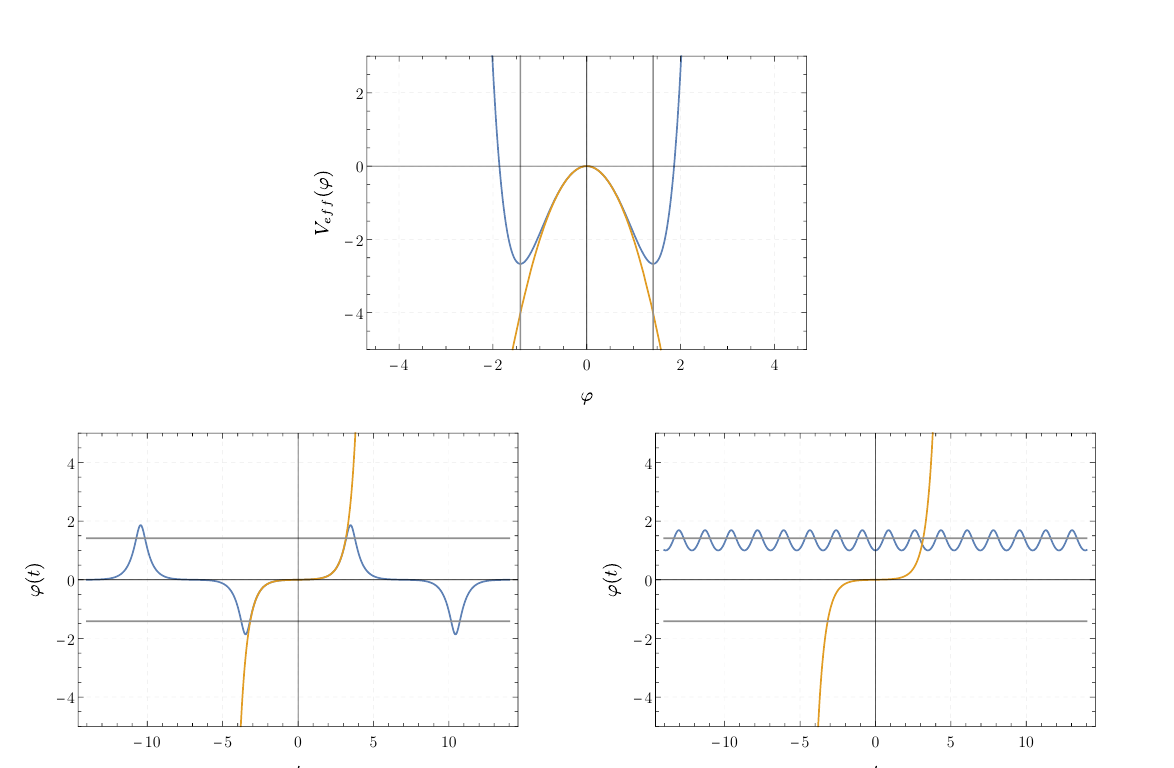
Figure 9 . Effective potential (top panel) and solutions to the field equations (bottom panel) in the case of a free tachyon (orange lines) and a tachyonic field interacting via a toy model for the effective potential, V ( φ ) = c = 1 are used 2 ϕ 2 + ϕ 6 / 6 (blue lines). The parameters m 2 = 2 GeV 2 and c eff th m th ±√ to generate the plots. Two straight gray lines at ϕ = 2 are drawn to facilitate identifying the position of the two minima in all plots. The solution ϕ ( t ) in the bottom-left panel is obtained by using the initial conditions ϕ (0) = 0 and ϕ 0 (0) = 0 . 1 , while the one on the right panel is generated for ϕ (0) = 1 and ϕ 0 (0) = 0 . The motion starts close to the unstable configuration associated with the tachyonic modes, and moves away from it. In the case of a free tachyonic field the potential is unbounded from below, since c 2 < 0 , and this generates the non-oscillating exponentially th m growing modes discussed in the previous section. Once an interaction is turned on, the potential becomes bounded from below. Correspondingly, the motion is oscillatory, and bounded both from above and from below, similarly to the case of standard particles. Specifically, the figure on the bottom-left panel describes the situation where the field’s kinetic energy overcomes the potential energy, and the field oscillates between the two stable vacua. In the second case, depicted in the bottom-right figure, the field oscillates about one of the two possible stable vacua, yielding an oscillatory motion very similar to that of stable